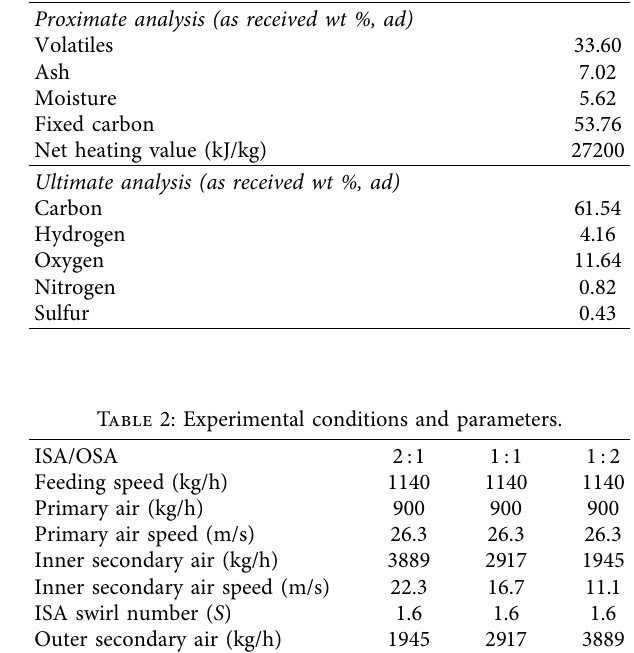
Table 1: The basic characteristics of experimental coal.